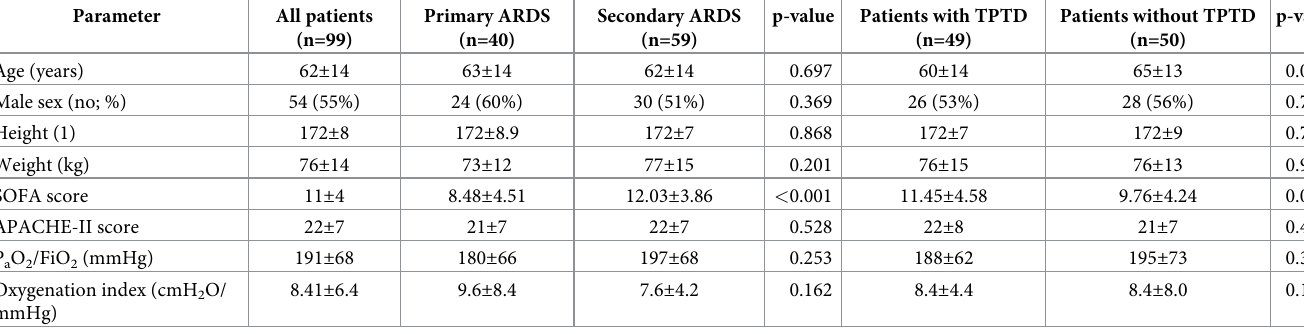
Table 2. Patients’ basic characteristics on day 1.